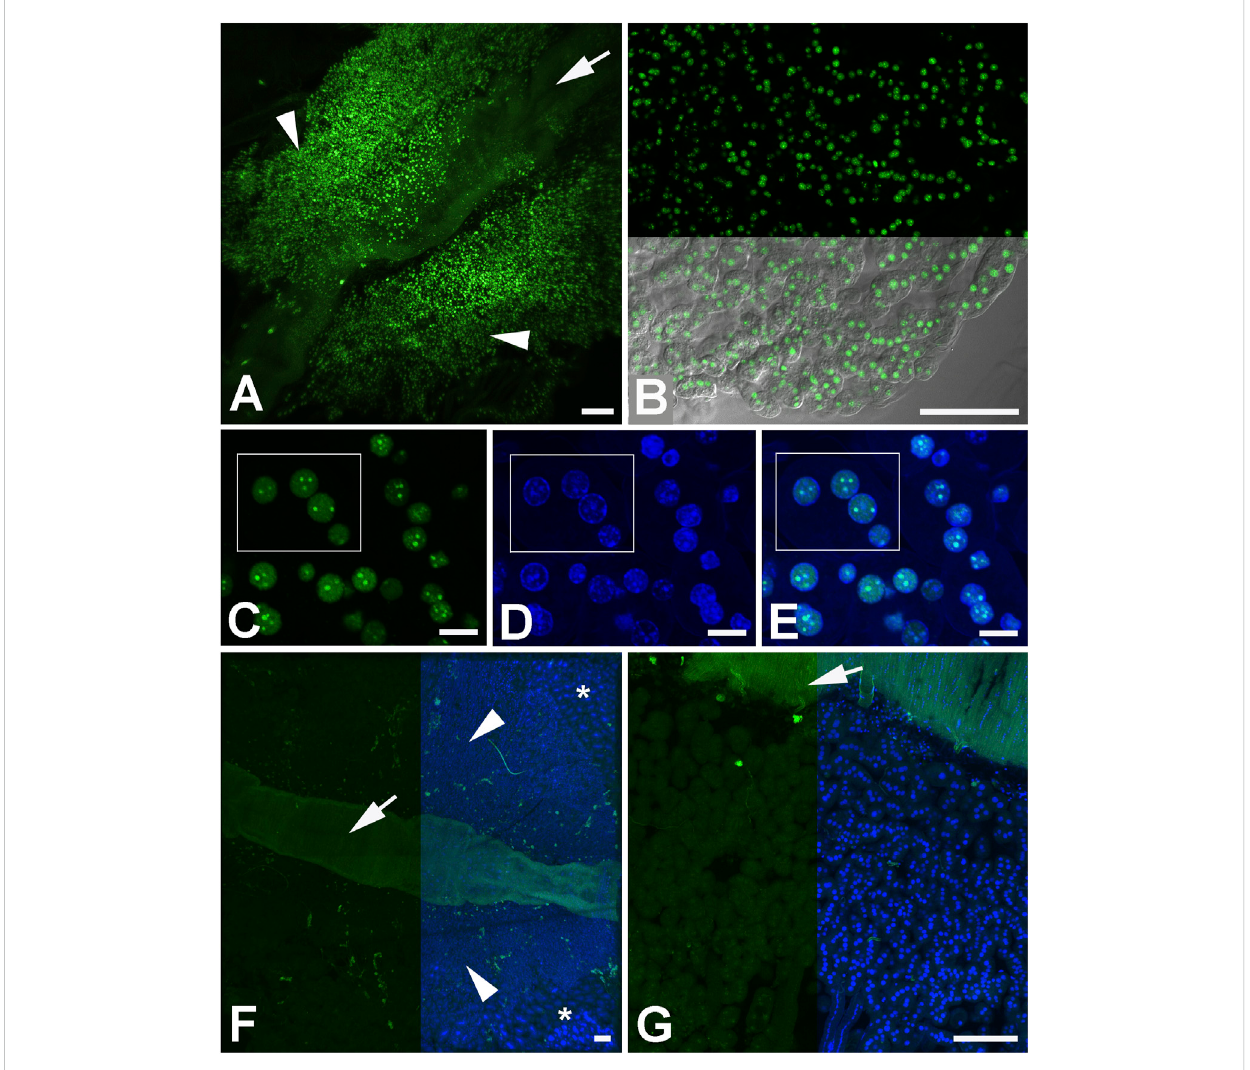
ActiveDNAsynthesisinthepericardialcellsofbumblebeecastes. (A – E) Pericardialcellsof5-to10-day-oldvirginqueens.Thewhiterectangle (C – E) surrounds a pericardial cell with 4 nuclei. (F) Pericardial cells of 1-year-old queens and (G) workers. The green color indicates localization of EdU incorporatedinactiveDNAsynthesis innuclei.Thegreen-blue colorrepresentscolocalizationofEdUsignalsandDNAlabelledbyDAPI(blue).Pericardial cells are indicated by arrowheads, the fat body is pointed by asterisks, and the abdominal aorta (heart) by arrows. Scale bars in (A,B,F,G) 100 µm and in (C,D,E) 10